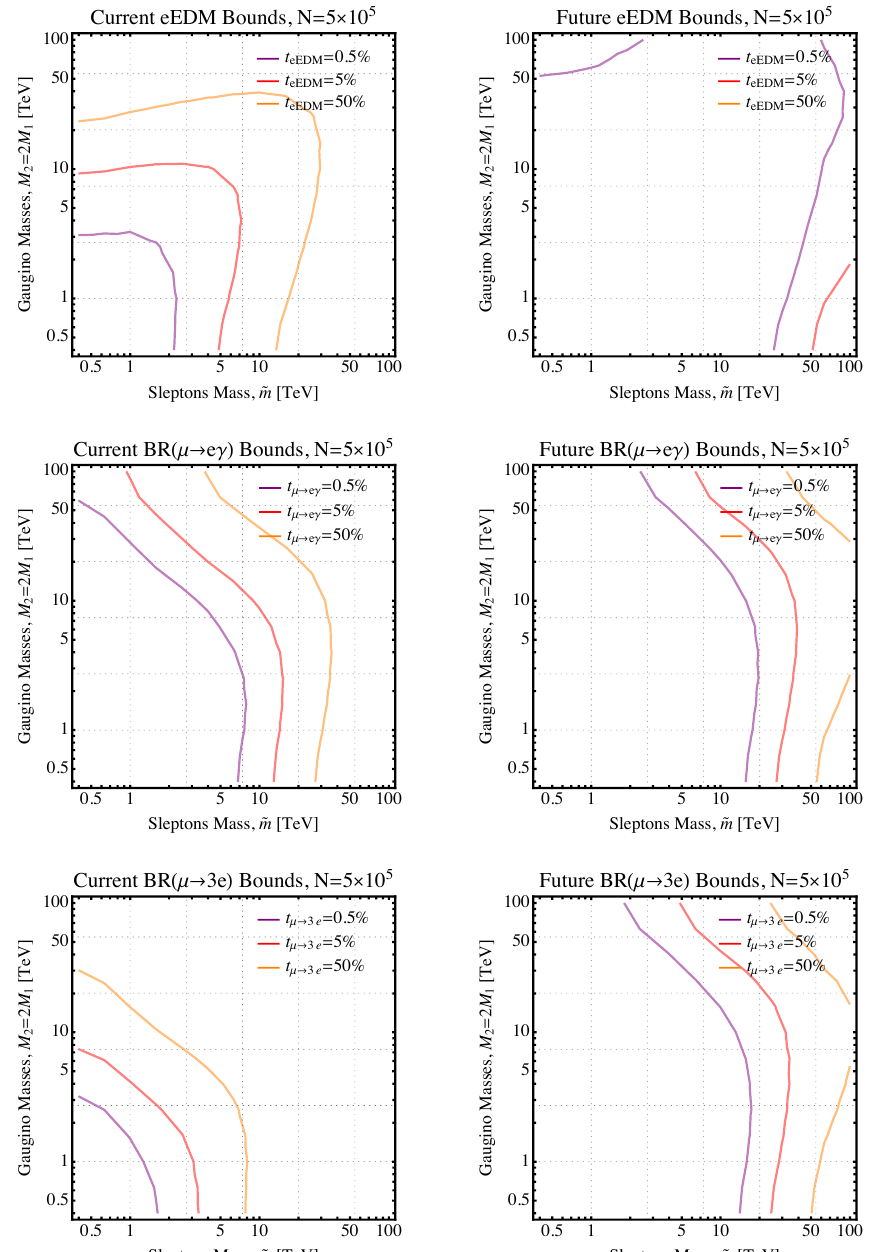
Figure 3 . The bounds on the charge assignment [ S 2 ] = − 3 and { [ L 1 ] , [ L 2 ] , [ L 3 ] , [¯ e 1 ] , [¯ e 2 ] , [¯ e 3 ] } = { 4 , 3 , 3 , 2 , 0 , − 2 } (the first row of table 1) from eEDM ( top ), BR ( µ → eγ ) ( middle ), and BR ( µ → 3 e ) ( bottom ), with different amount of tunings. A total of N = 5 × 10 5 trials are generated and only the good trials are used in calculating the bounds. The left (right) column shows the current (future) bounds from each observable. We find that for this model to be natural, i.e., tuning of ∼ 50% for each observable, the superpartners should be heavier than ∼ 10 − 50 TeV; around percent-level tuning for each observable is required to realize superpartners of mass O (1)